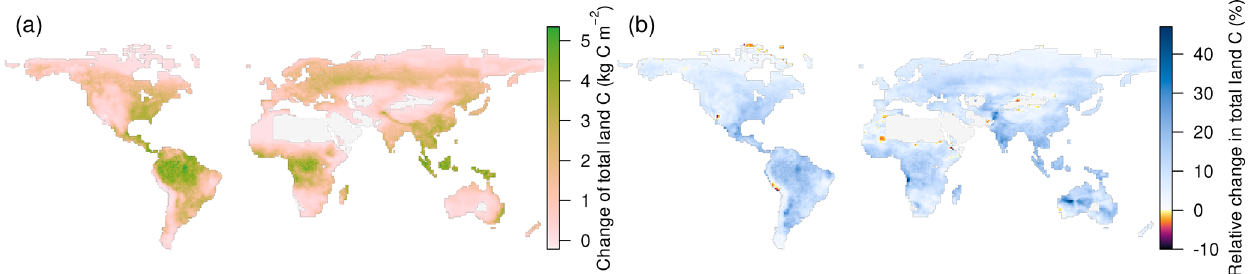
Figure 8. Multi-model means of absolute (a) and relative (b) changes in total carbon stocks (cTot; soil and vegetation carbon combined) from ∼ 1800 (average from 1800–1809) until today (average from 2009–2018) in the S2 simulation (including all environmental changes) within the vegetation extent of 1700. Grid points < 1kgCm − 2 cTot in the later period were